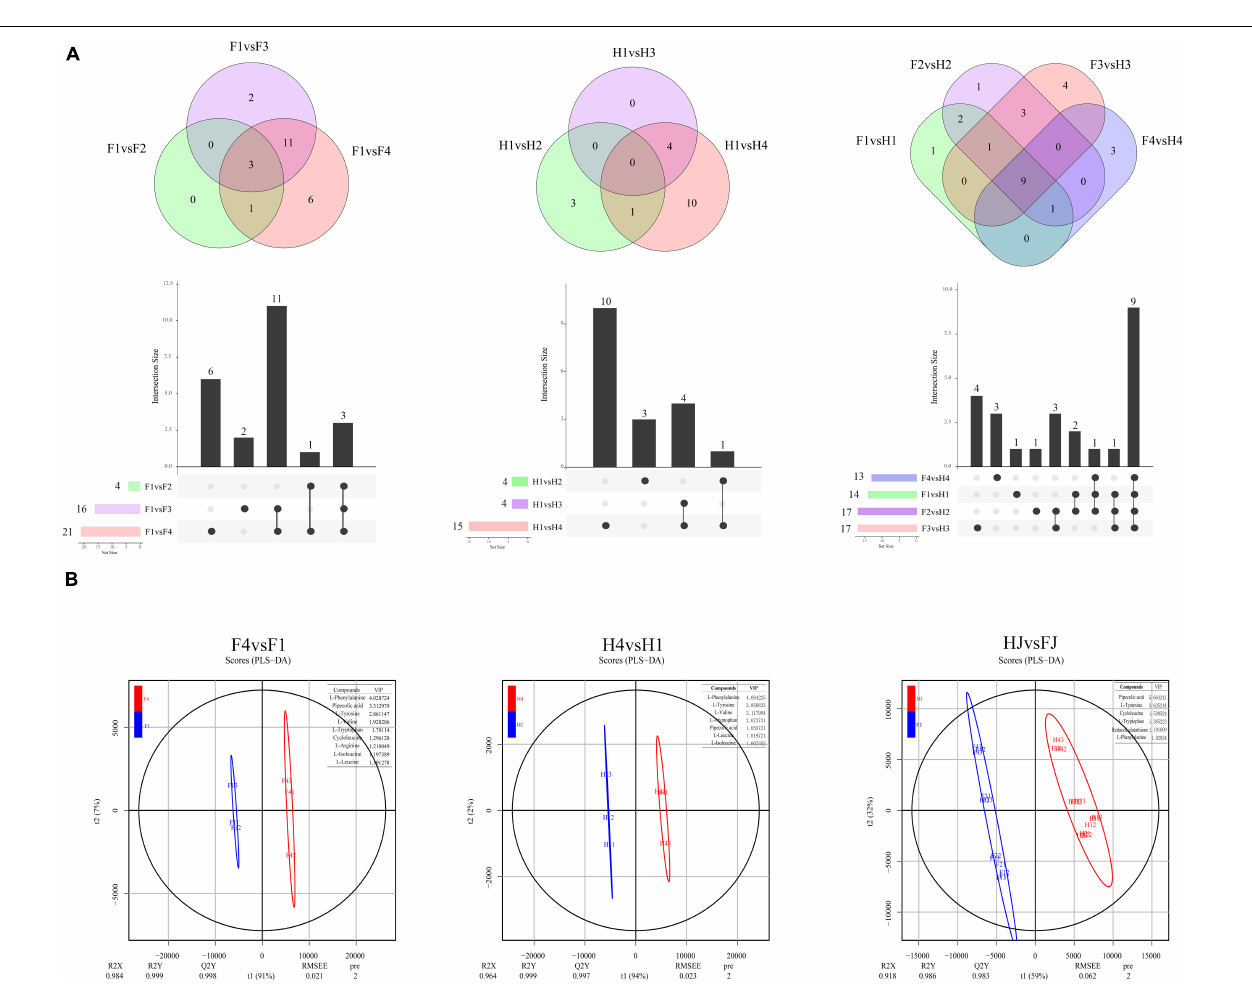
FIGURE 2 | Differentially analysis of amino acid in ZB leaves. (A) Venn diagrams of differentially accumulated amino acids (DAAs). The below columns presented the numbers of each group. (B) Orthogonal projections to latent structures discriminant analysis (OPLS-DA) in F4vsF1, H4vsH1, and HJvsFJ. The table on the top right position in each diagram showed the indicator DAAs and the corresponding variable influence on projection (VIP)